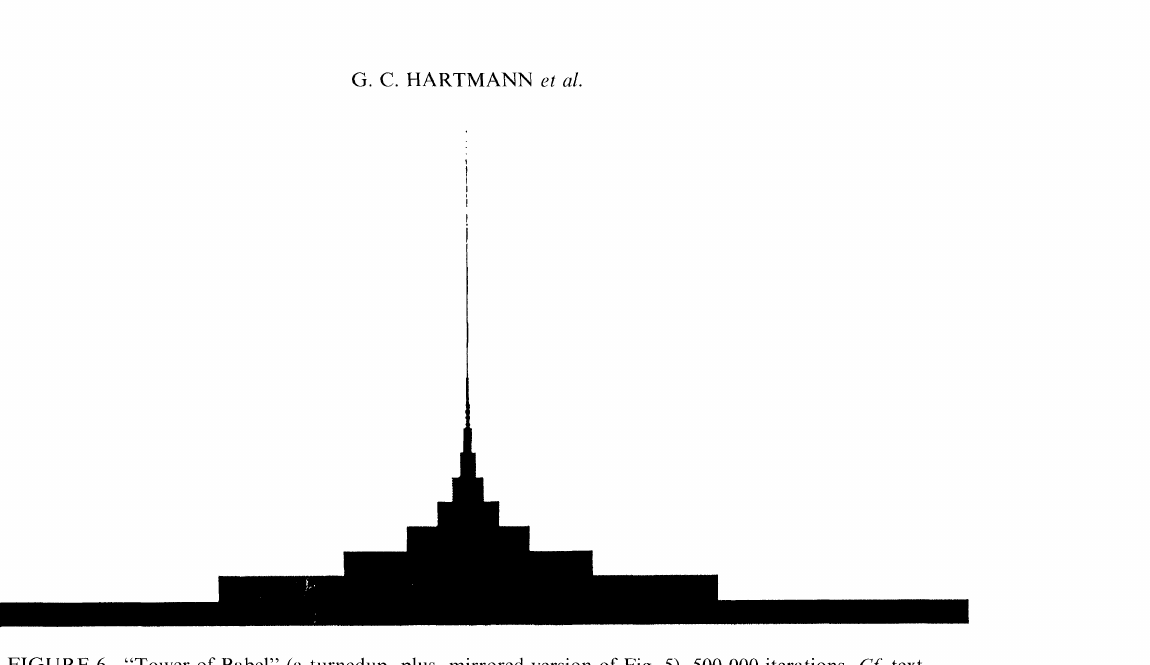
FIGURE 6 "Tower of Babel" (a turnedup- plus -mirrored version of Fig. 5). 500 000 iterations. Cf text.